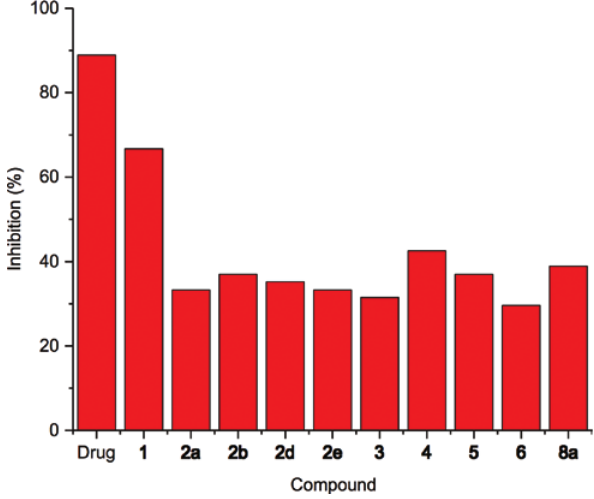
Figure 2: ABTS (inhibition %).